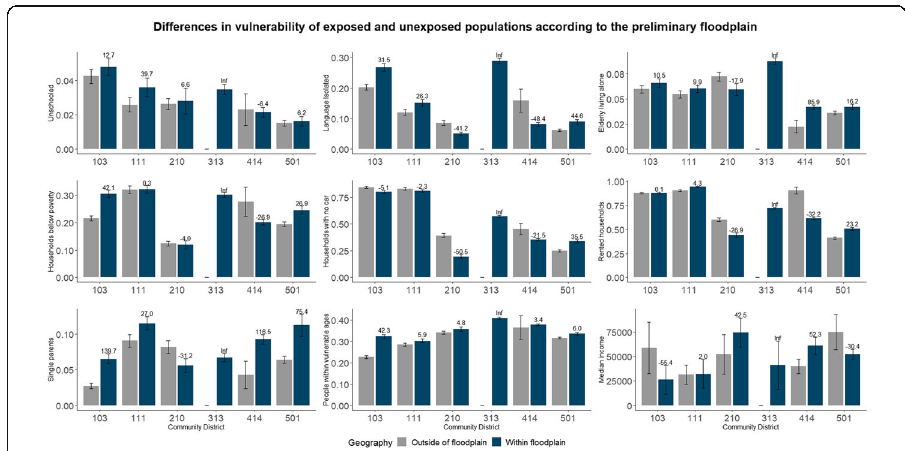
Fig. 8 Differences in vulnerability of exposed and non-exposed populations according to the preliminary SFHA. Error bars represent the Standard Error of those variables that correspond to ACS estimates, and asterisks indicate the statistical significance of the indicators showing p-values below 0.01 (***), 0.05 (**) and 0.1 (*). No asterisk means that there is no statistically significant difference. Red asterisks indicate that the exposed population is more vulnerable, while green asterisks indicate lower vulnerability. Labels on top of each second bar indicate the %